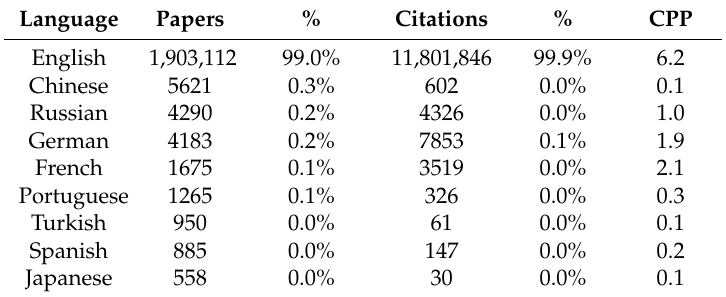
Table 2. Document languages ( n > 500) and their papers, citations, and citations per paper (CPP).